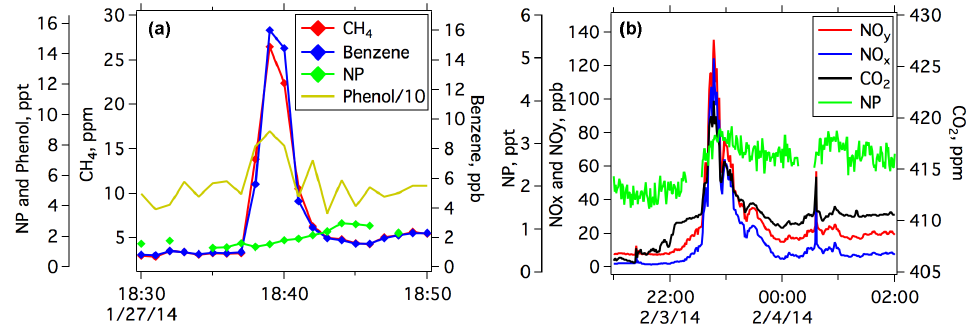
Figure 4. (a) An episode with high concentrations of methane and benzene on 27 January 2014 during UBWOS 2014. The source for this episode was fugitive emissions from oil and gas activities. (b) An episode with high concentrations of NO y and CO 2 on 3 February 2014 during UBWOS 2014. The source for this episode was fuel combustion (e.g., vehicle exhaust and/or other combustion sources for oil and gas